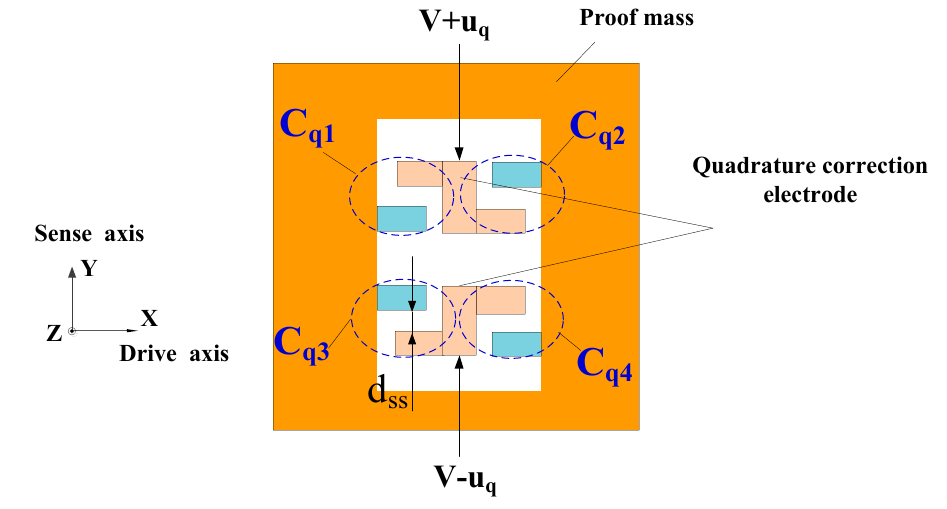
Figure 4. Quadrature error correction scheme.